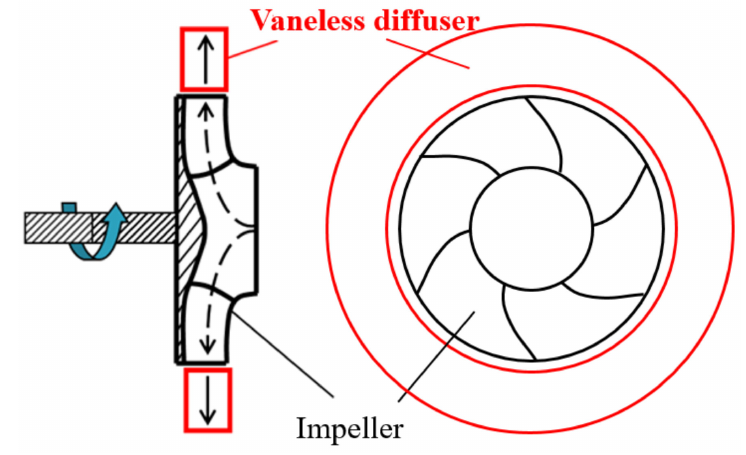
Figure 1. Sketch of a centrifugal